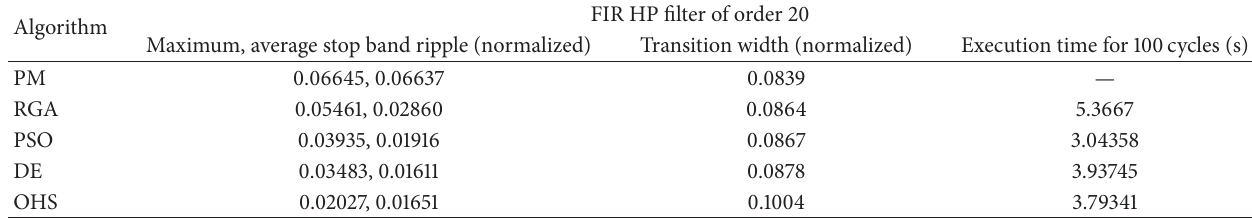
Table 8: Other comparative results of performance parameters of all algorithms for the FIR HP filter of order 20. Algorithm